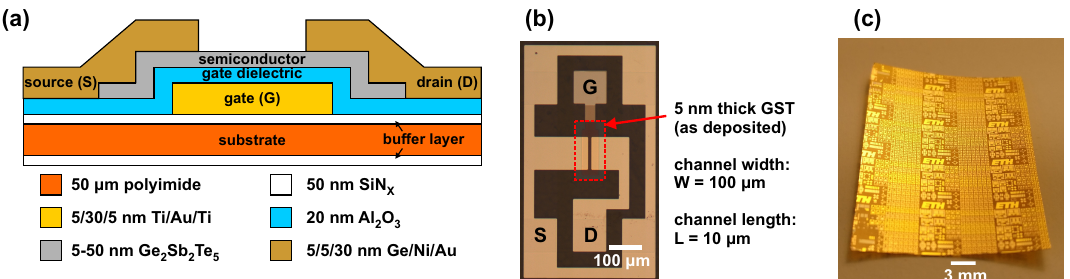
Figure 1. Thin-film transistors (TFTs) on flexible plastic substrates. ( a ) Schematic TFT cross-section. ( b ) Optical micrograph of a TFT top view. ( c ) Photograph of fully fabricated devices on 50 µ m thick polyimide.